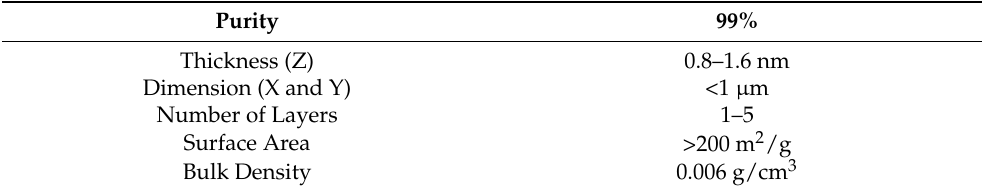
Table 1. Technical specification of the